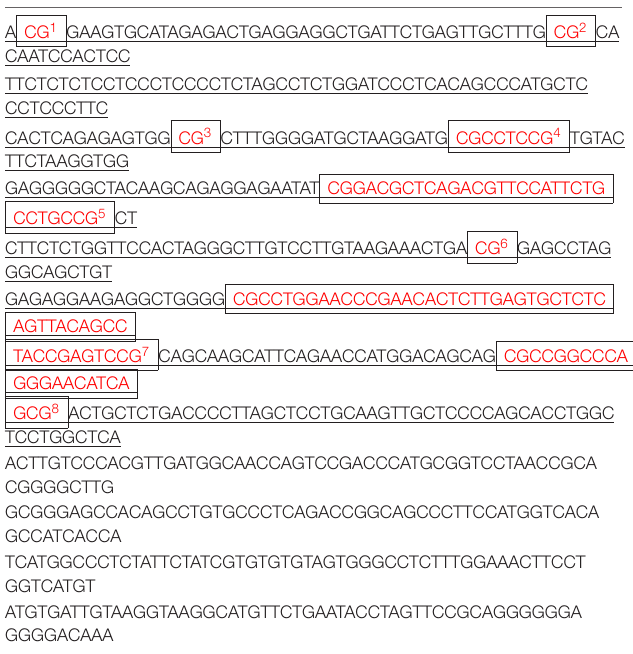
TABLE 1 | Eight regions of the 17 CpG islands in the Oprm1 gene promoter